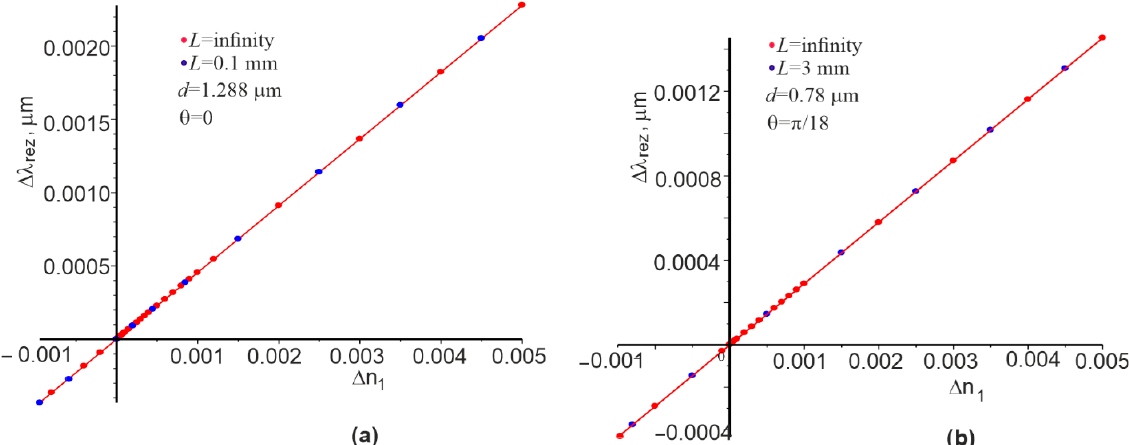
Figure 5. Dependence of ∆ λ rez on the change of refractive index ∆ n 1 for the Gaussian beam and the plane wave at the normal incidence of the Gaussian beam and the plane wave ( a ), and for the Gaussian beam and the plane wave incidence at the angle of π /18 ( b ). Straight red lines are drawn between the two extreme points corresponding to the minimum and maximum value of n 1